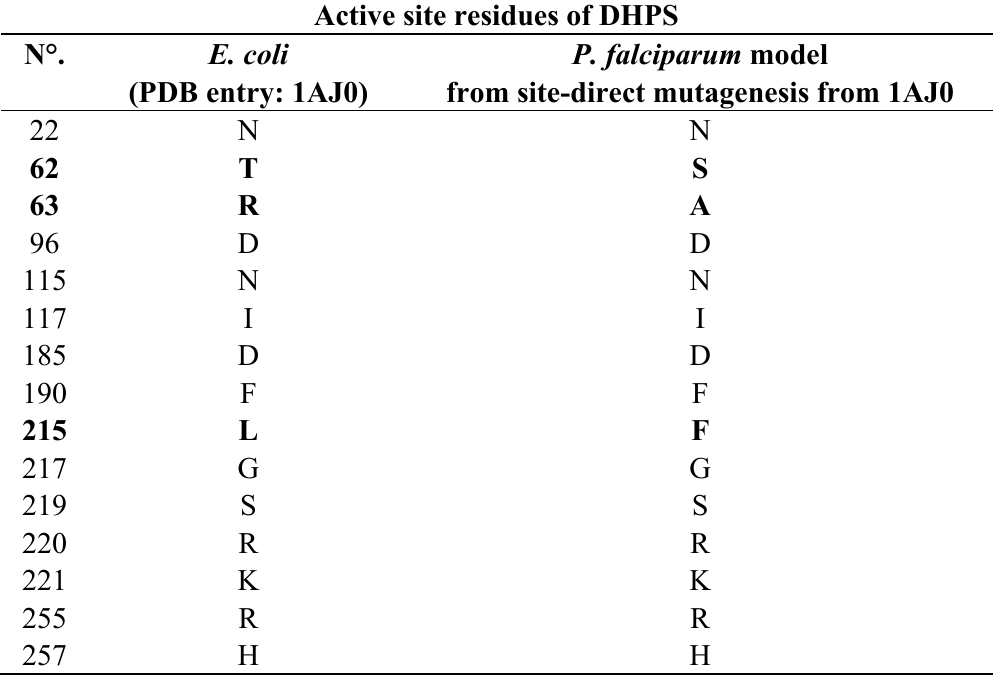
Table 1. Active site residues of both E. coli and P. falciparum